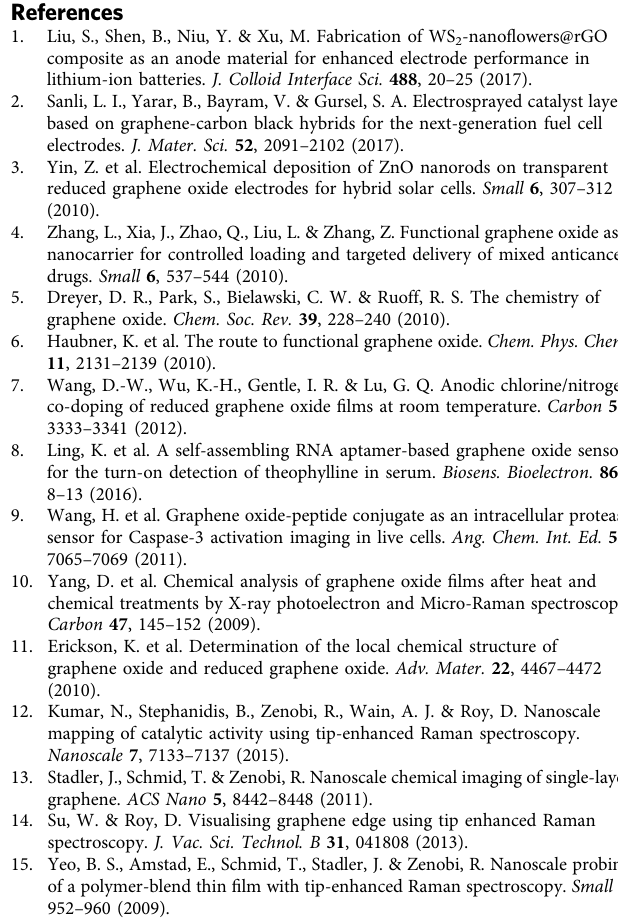
Fig. 1. A 638 nm excitation laser was focussed on the sample at an angle of 60° using a ×100, 0.7 NA, 20 mm long working distance objective lens (Mitutoyo, Japan). TERS spectra were measured using a spectrometer grating with 600 lines/ mm and an electron-multiplying charged-coupled device detector (Andor, Ireland) with a laser power of 100 µW at the sample. For fast and ef fi cient TERS mapping, TERS measurements were conducted in SpecTop ™ TERS mapping mode in which TERS spectrum at a particular pixel in the TERS map is measured when the tip is in direct contact with the surface, with a typical interaction force of 2 – 10nN and integration time of 0.05s – 0.5s. Transition between the pixels of the TERS map is performed in semi-contact mode, which preserves both the sharpness and plasmonic enhancement of the tip eliminating lateral forces that might otherwise sweep aside or pick up loosely attached contaminants from the sample surface. All TERS measurements were performed using Au coated AFM TERS tips ( k = 7 N/m, f = 150kHz, formerly AIST-NT, now HORIBA Scienti fi